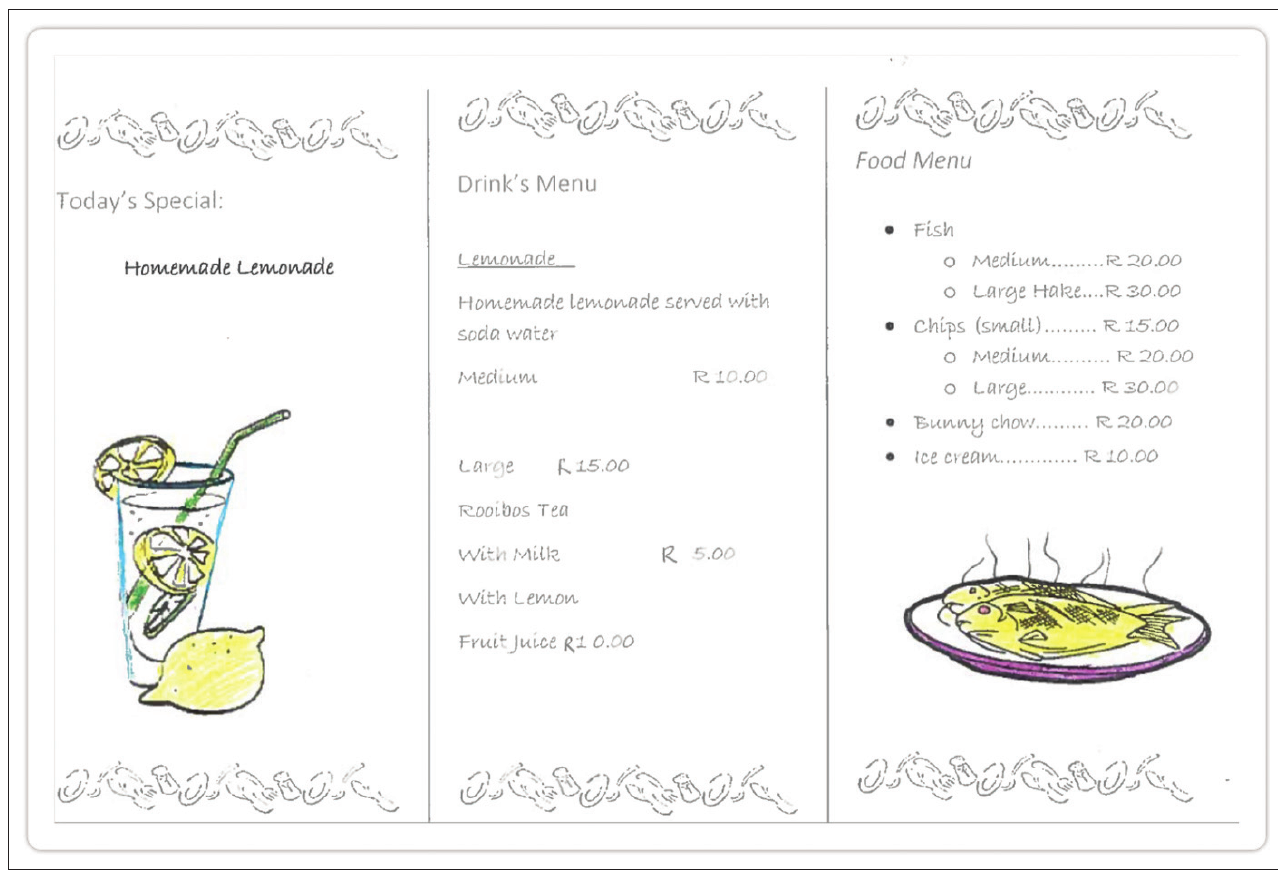
FIGURE 2: The menu item detailed and priced by the learners during the building belief stage. Hellemann designed the menu in collaboration with the